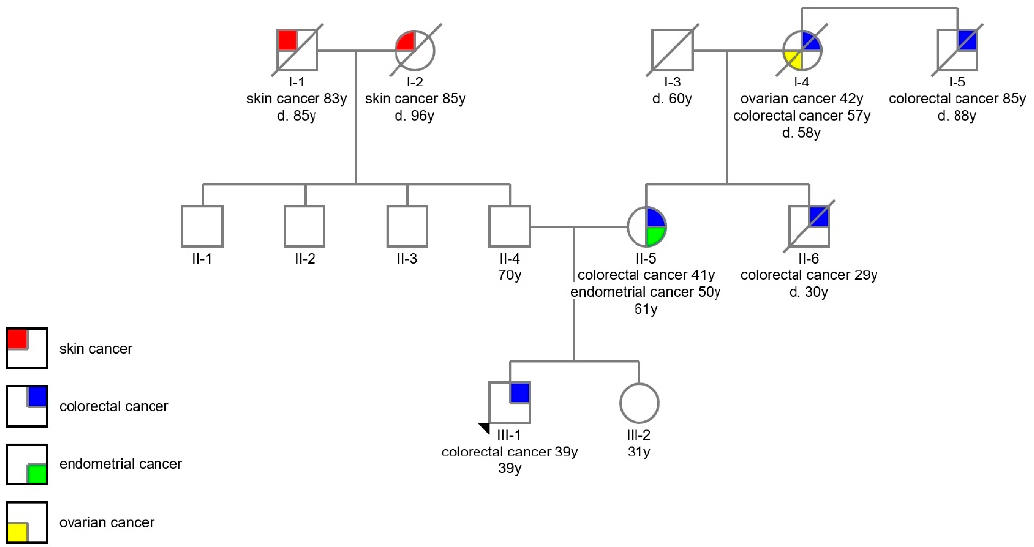
Figure 1. The genealogies including age and cancer types.